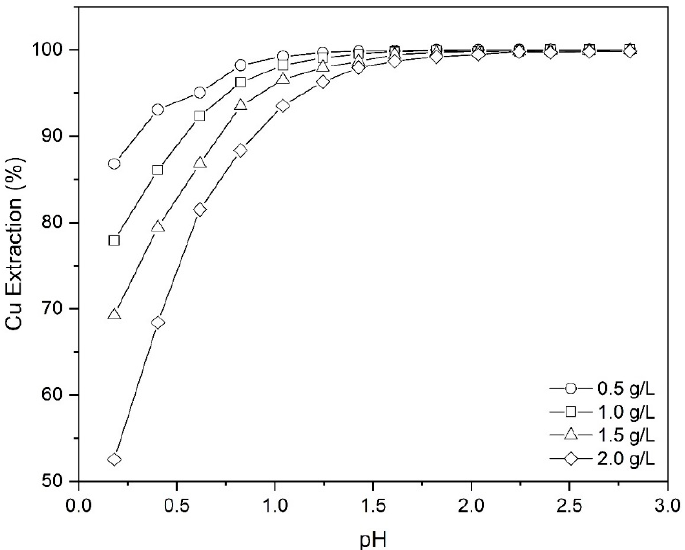
Figure 7. The effect of initial Cu concentration on copper extraction at different pHs (Mextral 5640H = 10% ( v / v ), T = 25 °C, t = 10 and O/A = 1 and rpm = 400). To determine the number of extraction stages required at the chosen volume phase ratio (O/A = 1) of Mextral 5640H, an extraction isotherm (McCabe–Thiele diagram) was plotted between the amount of copper extracted by the solvent and copper left unextracted in the raffinate at different O/A ratios at pH = 1.6. As shown in Figure 8, a two-stage counter-current extraction would achieve an extraction efficiency of 99.5% Cu at pH 1.6, 10% ( v / v ) Mextral 5640H in kerosene, stirring speed 400 rpm, contact time 10 min and room temperature (25 ◦ C).